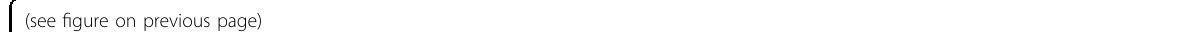
Fig. 1 The properties of HGF/U-Ms and VEGF/U-Ms are maintained on stent material. a Schematic illustration of the experiment using the stent with HGF/U-Ms and VEGF/U-Ms to secrete the angiogenic factors in an inducible manner. The stents were coated with polydopamine, fi bronectin, and extracellular matrix (ECM), followed by in vitro and in vivo swine experiments. b Human U-Ms secreting HGF and VEGF were seeded onto the pre-coated material sheets to con fi rm cell viability on the stent material. The cells stained with green fl uorescent dye were detected using material and staining of dying cells using trypan blue (**denotes a p -value < 0.01). d Cell viability was analyzed using a crystal violet assay on the stent 7 days post seeding (** denotes a p -value < 0.01). d , e HGF and VEGF secretion were detected in conditioned media using western blotting.